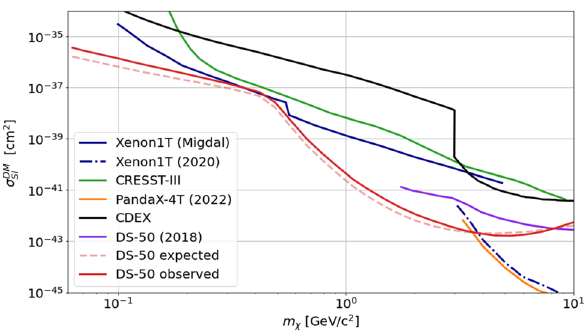
Fig. 9 The 90%C . I . observed limit on the DM cross-section σ DM functionoftheDMmass(redsolidline)withtheinclusionoftheMigdal effect for the final DS-50 exposure of 12202 ± 180 kg d. The blue line is the frequentist 90% C.L. from the XENON1T Migdal search [2], the blue dashed-dot line is the one from the XENON1T NR search [3], the greenlineistheonebytheCRESST-IIIexperiment[77],theorangeline is the one by the PandaX-4T experiment [4], the black line is the one by the CDEX experiment [8,78], and the purple line is the one from the 2018 DS-50 pure NR analysis [1]. The pink dashed line is the expected